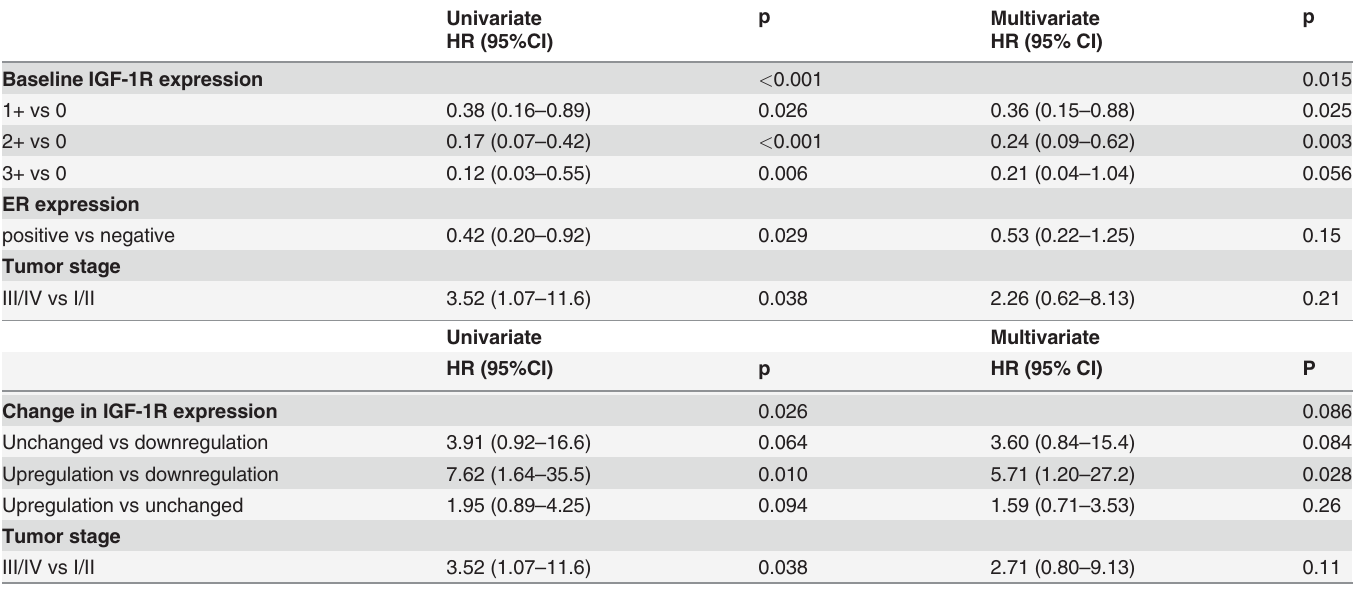
Table 4. Cox proportional hazard regression